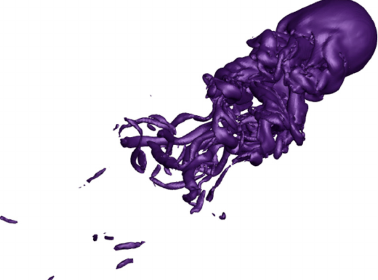
Figure 26. Vortex structure of the flow past a sphere at Re = 1000.